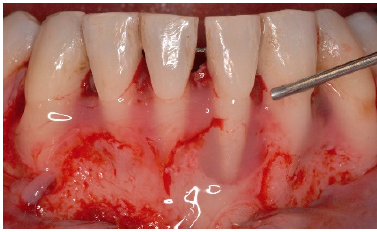
Figure 5. Following root surface conditioning with EDTA gel in a neutral pH for 2 min, enamel maytix proteins derivative gel (EMD) was applied onto denuded root surfaces.